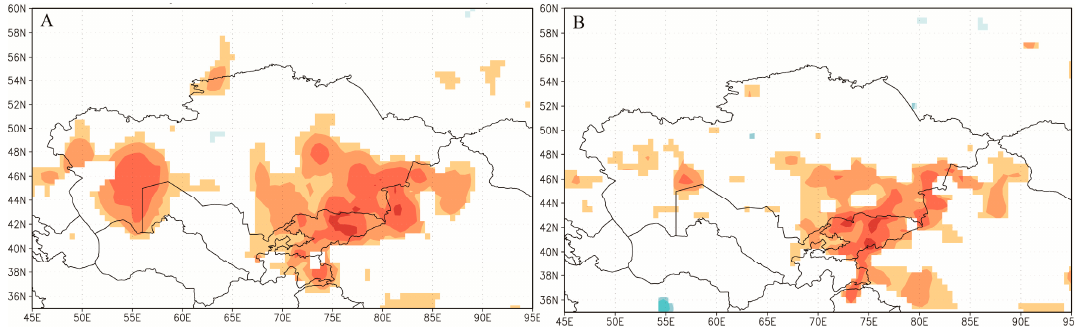
Figure 5. Comparison of SPEI reconstruction from this study and other studies in the western Tianshan Mountains. ( A ) Reconstructed SPEI in Chu River Basin (this study); ( B ) Reconstructed precipitation in southern Kazakhstan [9]; ( C ) Reconstructed PDSI in Dzungarian Alatau [10]; ( D ) Reconstructed precipitation in Issyk-Kul, Kyrgyzstan [7].